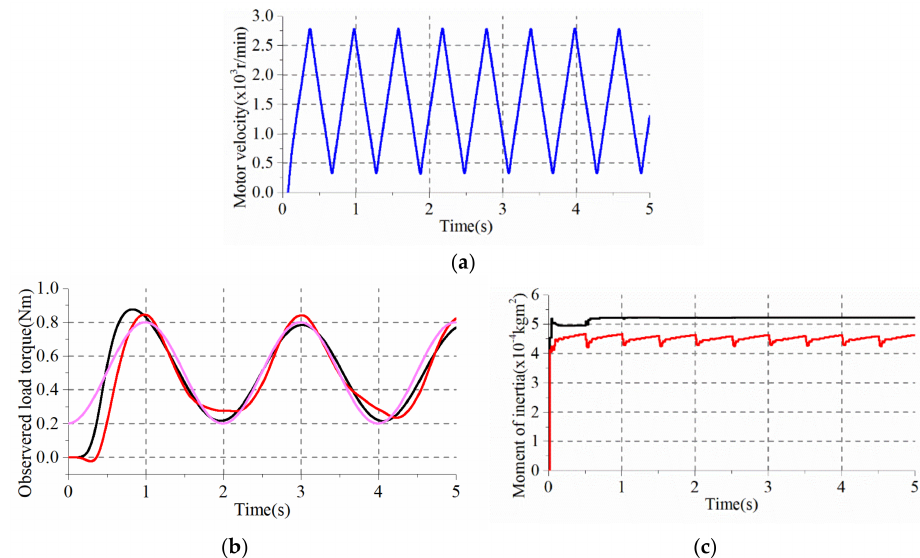
Figure 5. Simulation Comparison of the two algorithms under sine-wave load torque and triangle-wave speed command. ( a ) Speed response (blue); ( b ) Observed load torque ˆ T L (pink line denotes the true load torque, black line denotes AKO-RLS result, red line denotes KO-RLS result); ( c ) identified inertia ˆ J (black line denotes AKO-RLS result, red line denotes KO-RLS